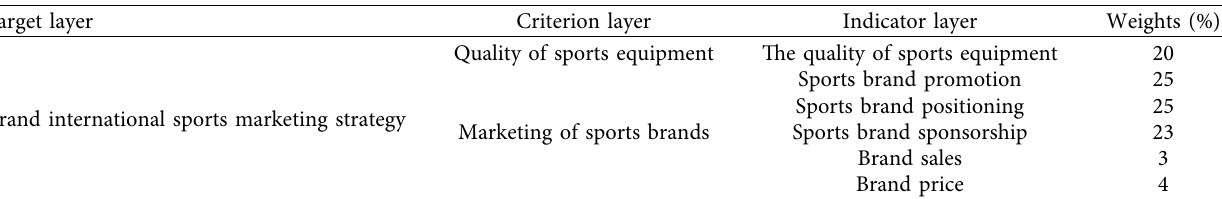
Table 4: The fuzzy AHP result